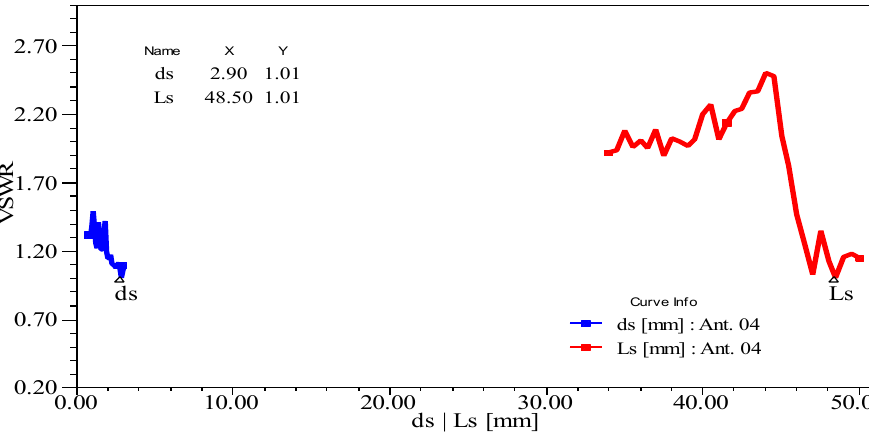
Figure 15. VSWR of slot antenna 4 at 2450 MHz versus ds and Ls (mm).